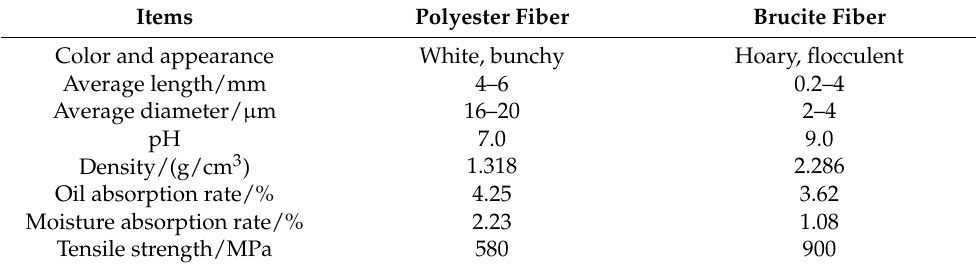
Table 3. Basic technical characteristics and properties of the two